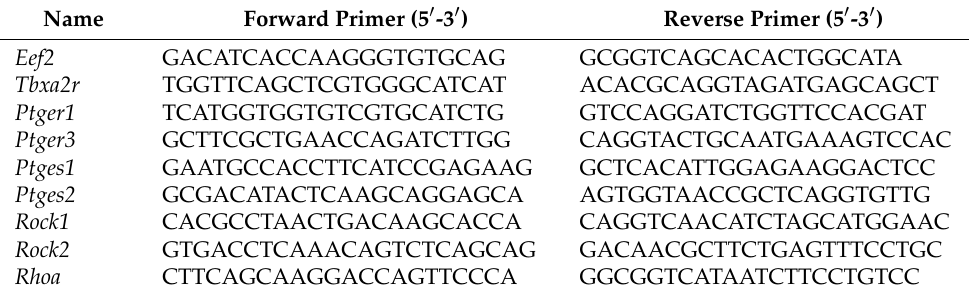
Table 1. Primer list for